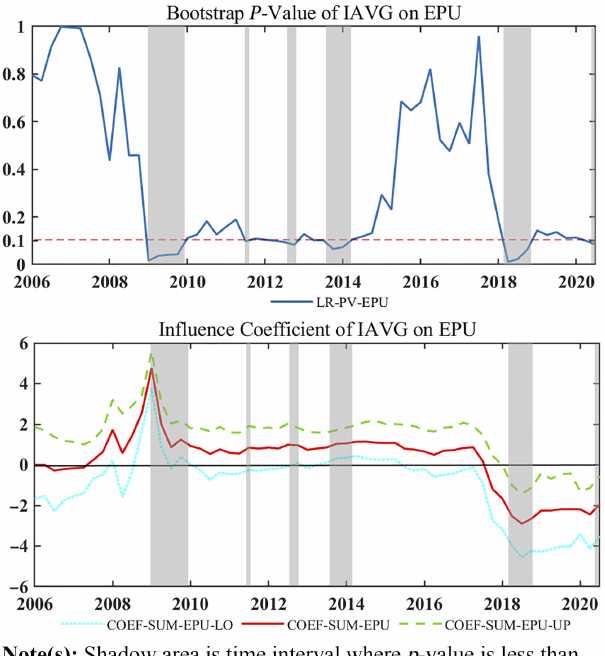
Figure 2. Sub-sample bootstrap rolling window causality test of IAVG on